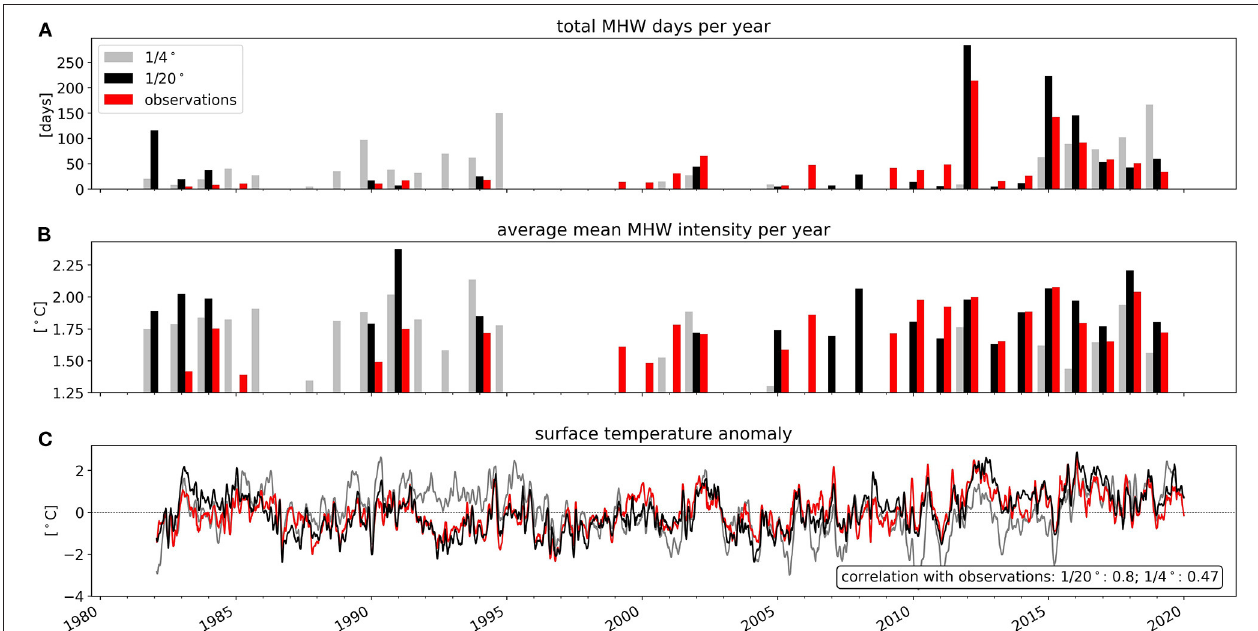
FIGURE 4 | MHW metrics in simulations and observations; total MHW days per year (A) , average mean intensity per year (B) and SST anomalies (30 day rolling window) based on the whole period for ORCA025, VIKING20X and OISST in gray, black and red, respectively for the overlapping data period from 1982-2019 (timeperiod also used as baseline for MHW detection); correlation values of the simulations to the observations are shown in (C) . All metrics are based on spatially averaged temperatures over the three